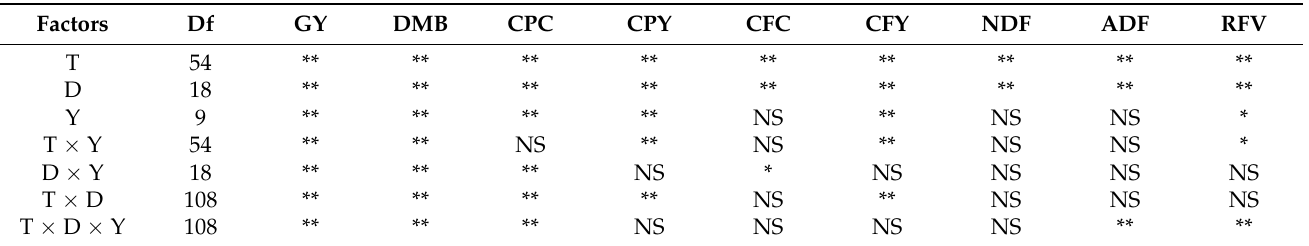
Table 4. The forage yield and quality of oat and common vetch in the sole and intercropped systems under different seedling periods in 2015 and 2016.